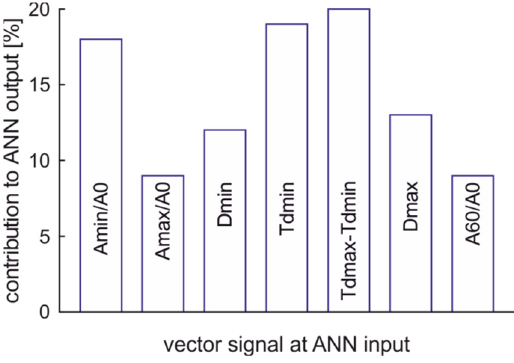
Figure 16. The contribution of input values to ANN classifier output of fuel quality type.